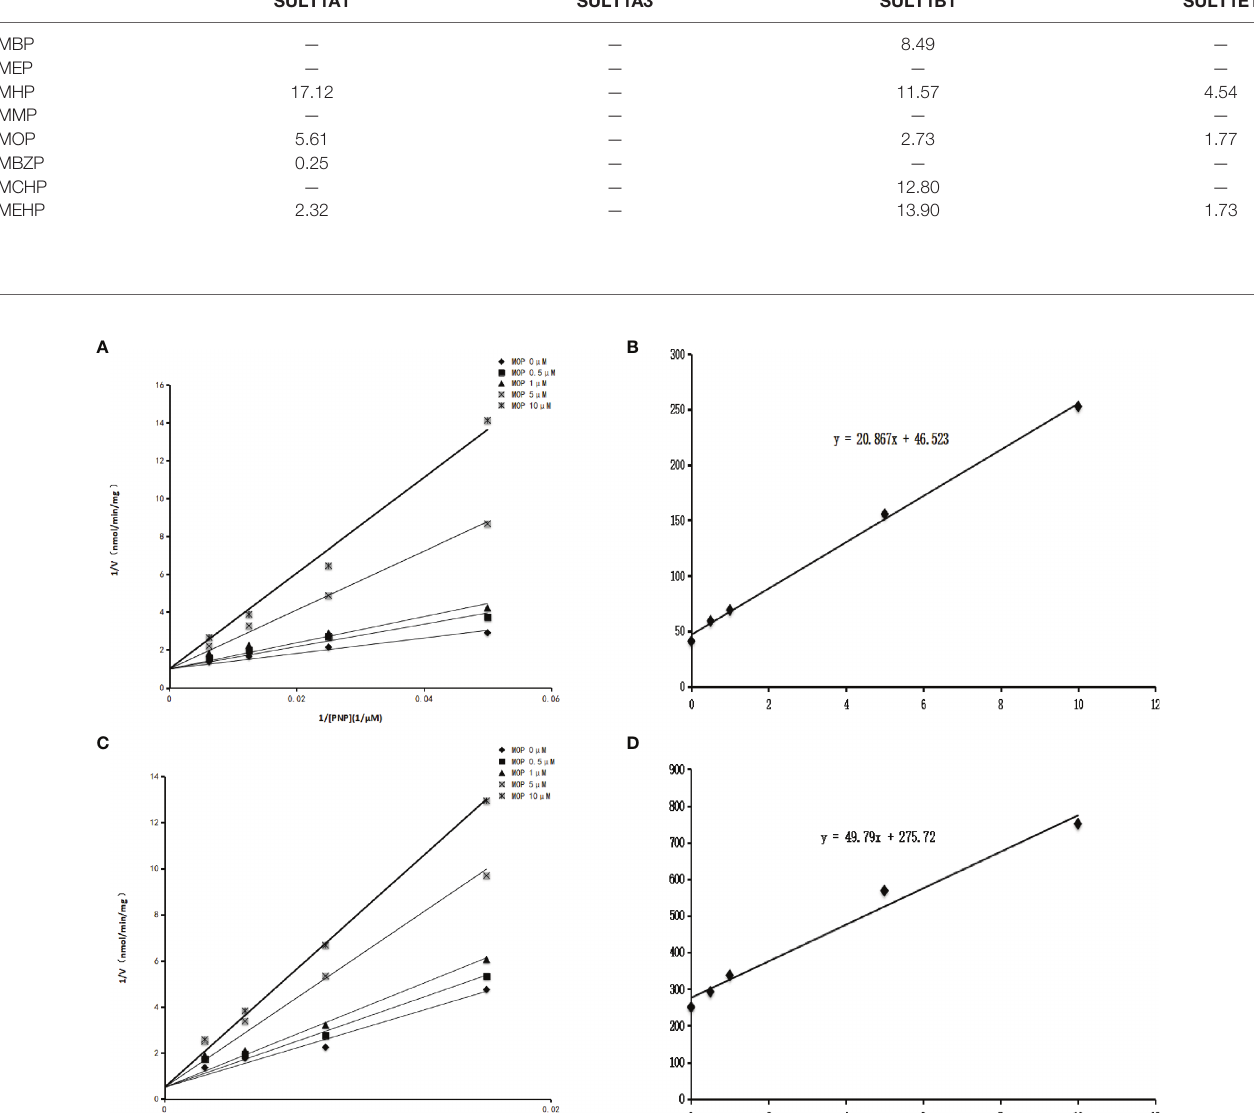
( Figure 7A ). MOP formed three hydrogen bonds to SER-139, ARG-131, and LYS-48 ( Figure 6B ), and 4 hydrophobic contacts were formed between MOP and the active cavity of SULT1B1 ( Figure7B ).ThebindingfreeenergyofMBP, MHP, MOP, MCHP, and MEHP towards SULT1B1 were − 7.66, − 8.05, − 8.23, − 8.92, and −